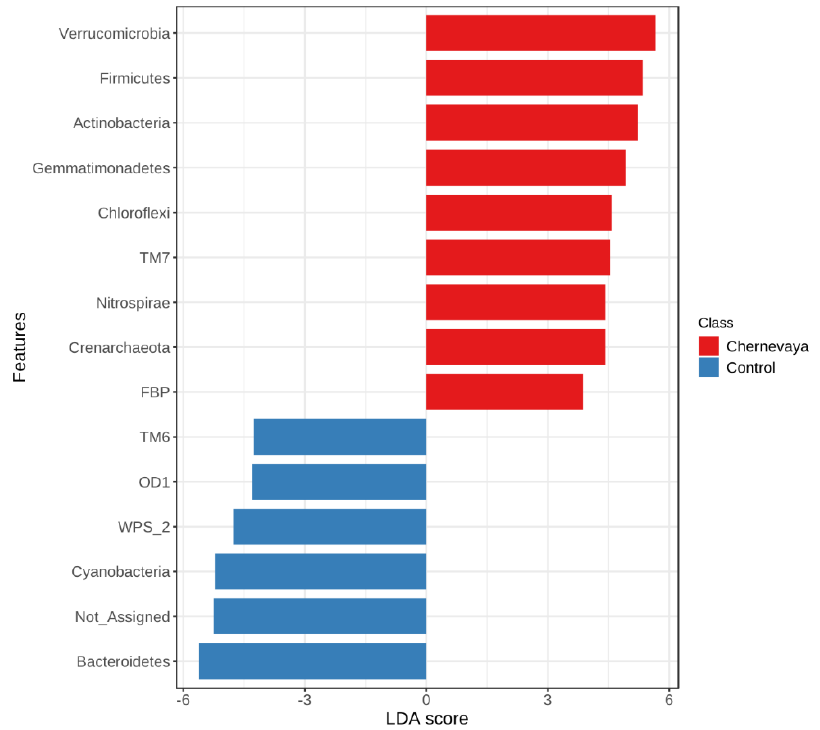
Figure 5. Effect size (LDA) for the prokaryotic phyla in the rhizosphere of plants growing on the Chernevaya soil relative to those on the control soil. Only taxa recruited in rhizospheres of all plants in study (“root generalists”) were taken into account. LDA score is a log10 transformed, absolute threshold 2, FDR-adjusted p -value cutoff 0.05. See Supplementary Table S2 for the analysis result for each taxonomic level.